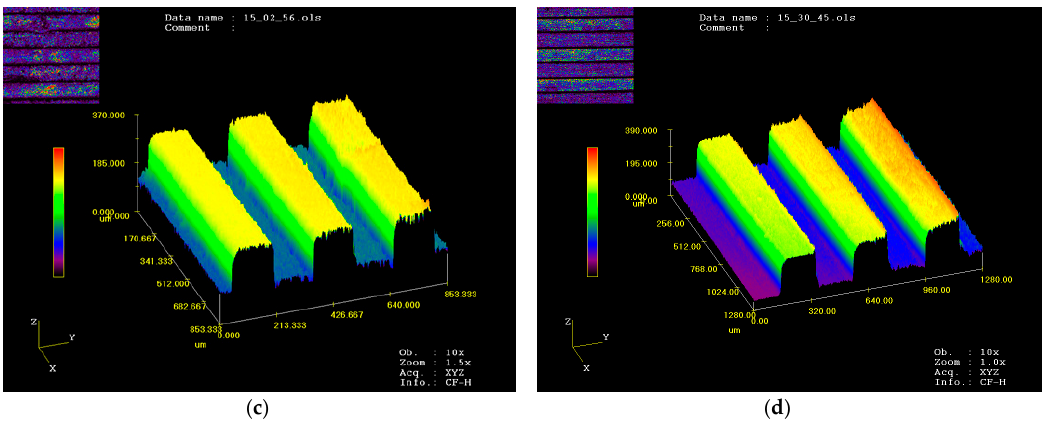
Figure 7. Profile measurements of micro-array channels with different widths: ( a ) 50 μ m; ( b ) 100 μ m; ( c ) 150 μ m; ( d ) 200 μ m. Table 1. Filling quality measurement of micro-array channels after micro-embossing using UFG LZ91 Mg-Li alloy ( μ m).